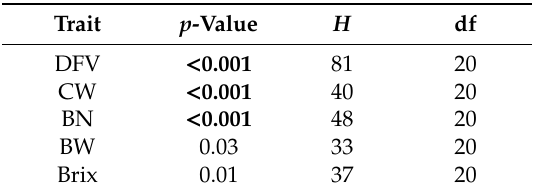
Table 2. Kruskal-Wallis rank-sum ( H ) test for phenology and berry traits. The p -value, H statistic, and degrees of freedom (df) for the five analyzed characters are presented. DFV: days from flowering to veraison; CW: cluster weight; BN: berry number; BW: berry weight; Brix: degrees Brix. Significant p -values after the multiple comparison test are highlighted in bold.